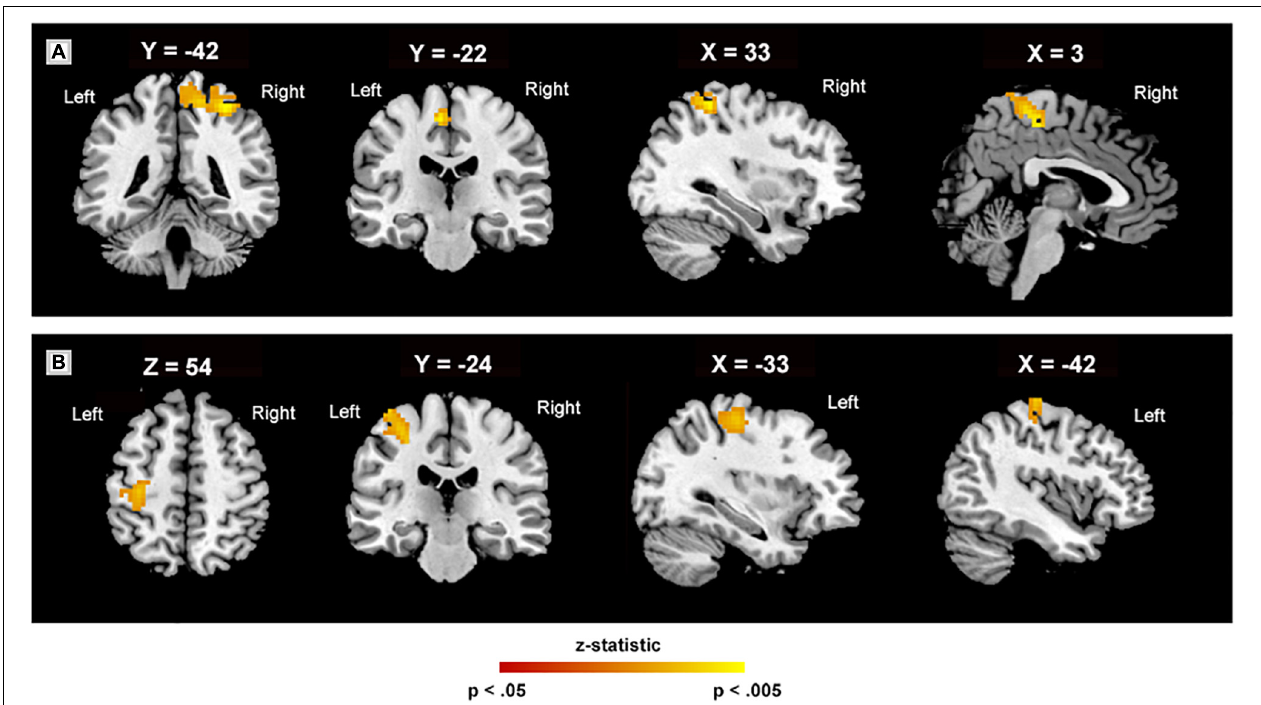
FIGURE 2 | Regional homogeneity in various regions. Regional homogeneity peaks (A) in the right superior parietal lobule, extending into the left supplementary motor area and mid-cingulate gyrus (328 voxels); (B) in the left postcentral gyrus, extending into the precentral (126 voxels). The white labels indicate the coordinate of each slice in the Montreal Neurological Institute and Hospital (MNI) frame of reference ( x , y , and z ) (cluster level, threshold at p < 0.05, family-wise error corrected).